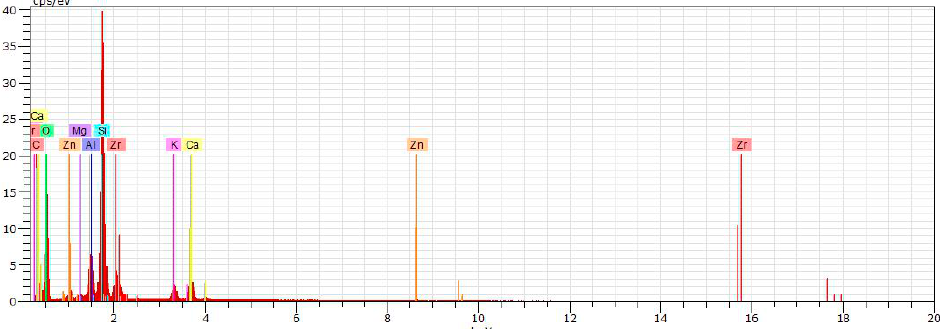
Figure 13. EDS of the second glaze layer or final glazing of ZrO 2 .